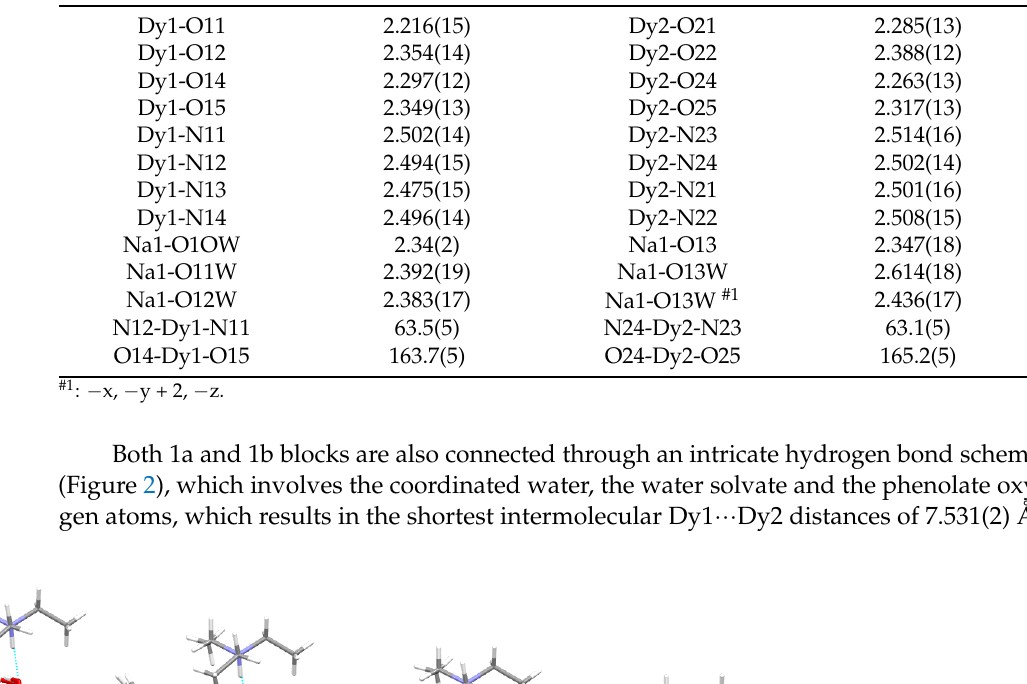
+ cations and water 3 NH